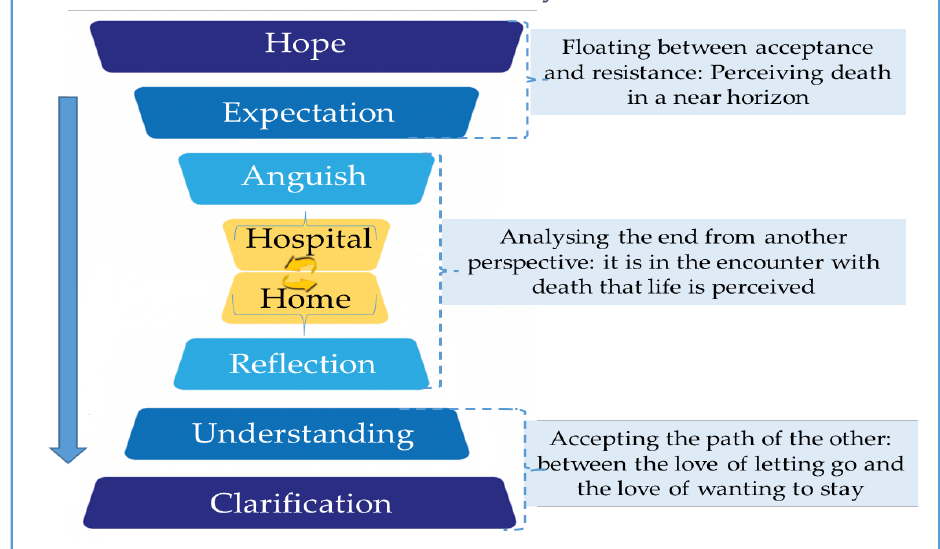
6 of 17 Table 1. Sample characteristics ( n = 21 participants). Characteristics